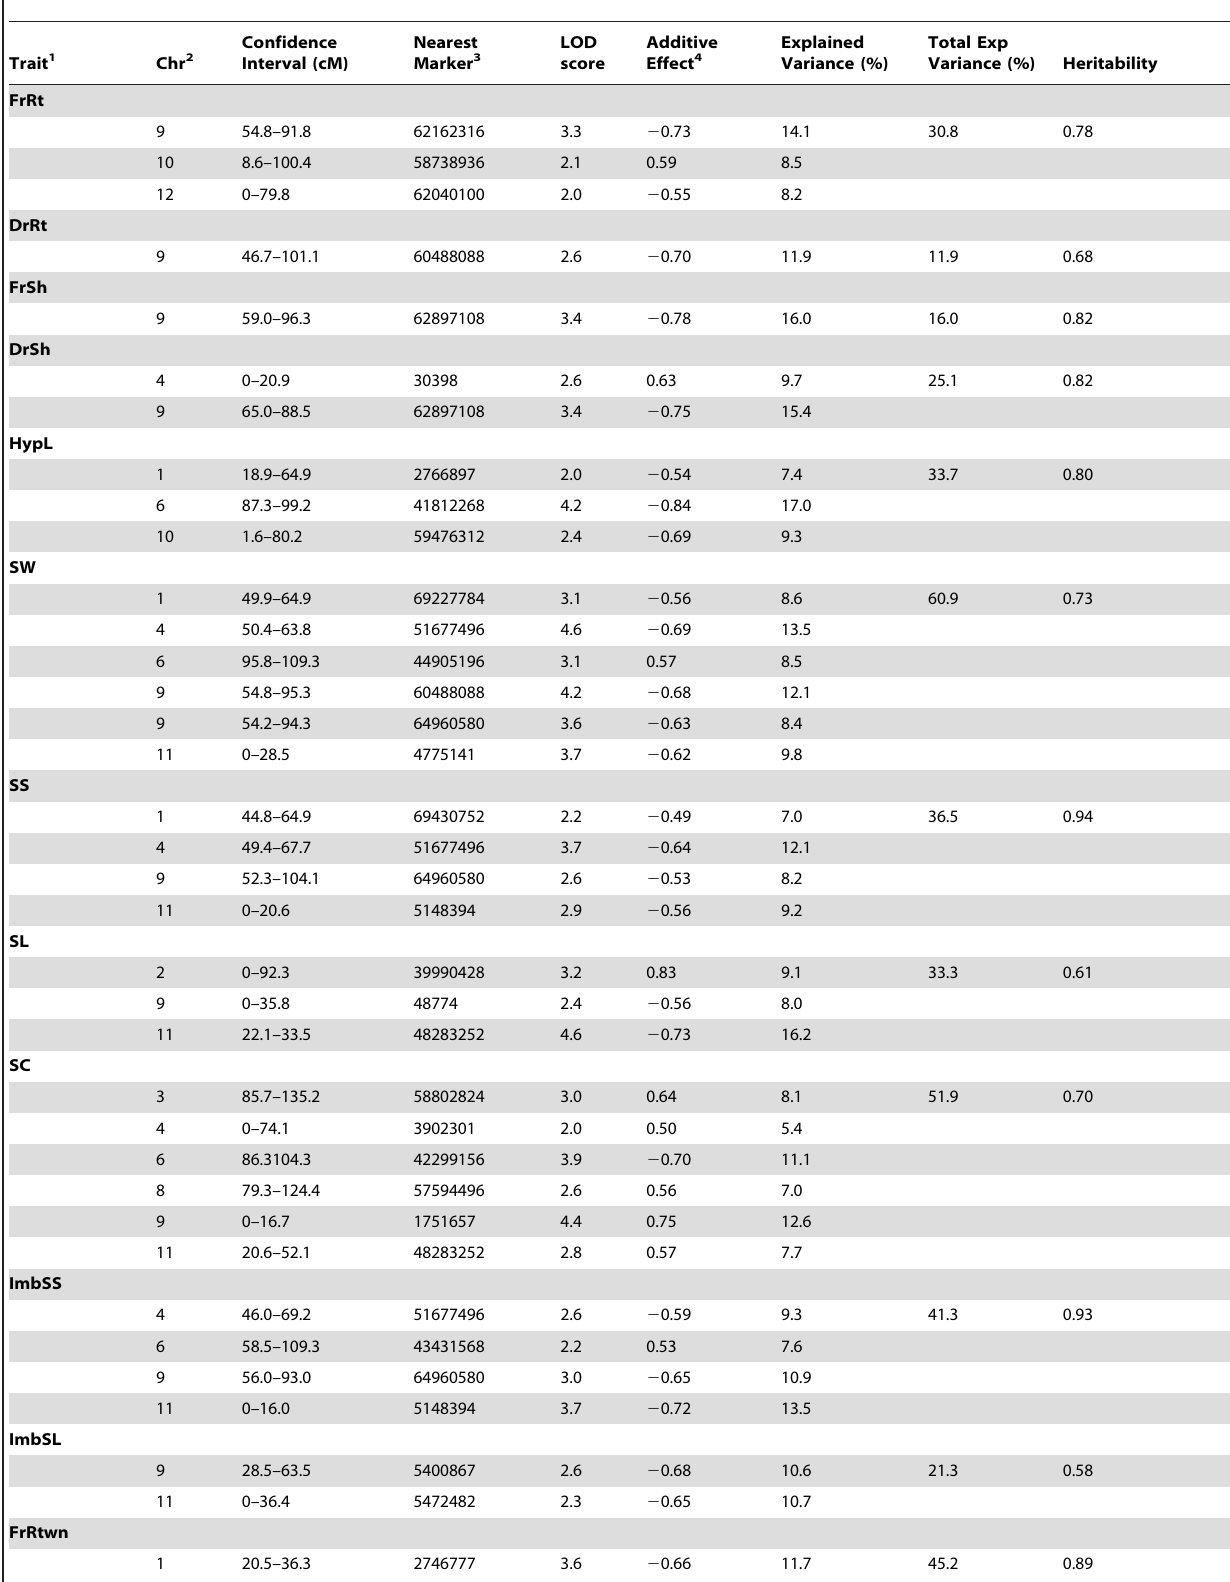
Table 3. Overview of significant QTLs associated with seed and seedling traits of S. lycopersicum and S. pimpinellifolium tomato RIL